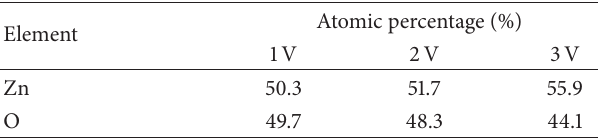
Table 2: Average compositional ratios for 1V, 2V, and 3V applied potential from EDX spectroscopy.